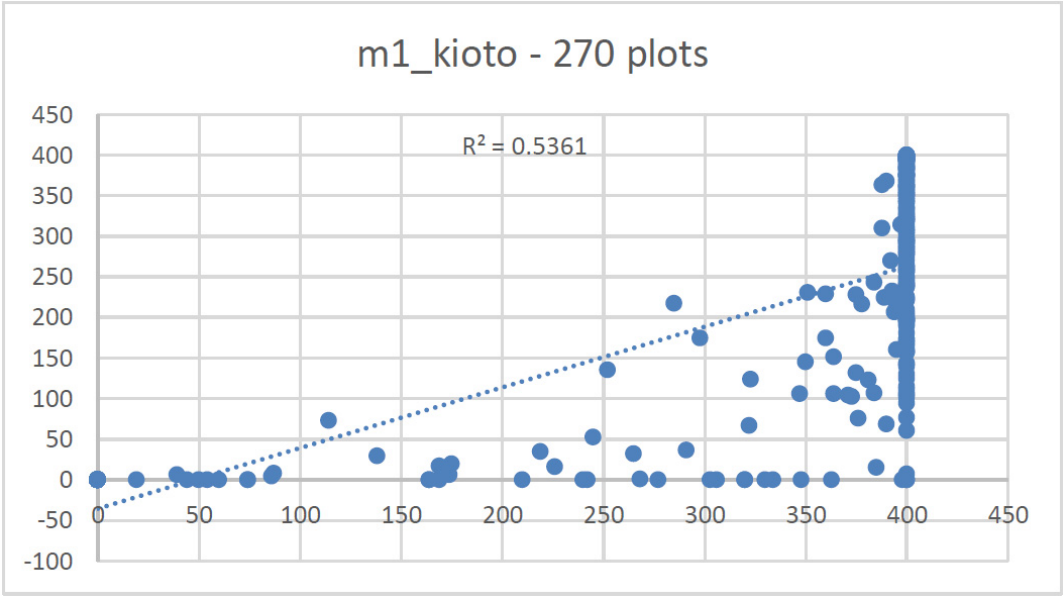
Figure A10. Reference area compared to estimated forest area by Method 1 for test plots (10 × 10 m 2 ) as defined by the UNFCCC.